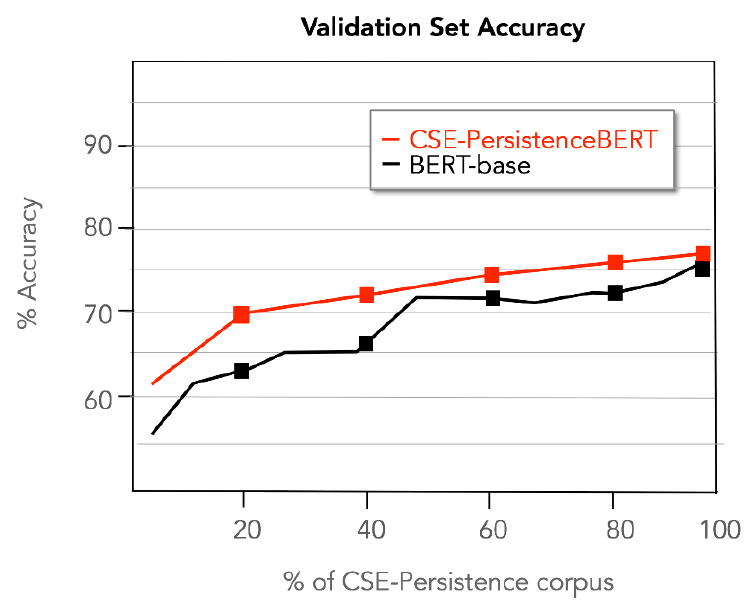
Figure 6. Comparison of accuracy on the validation set as a function of corpus percentage.